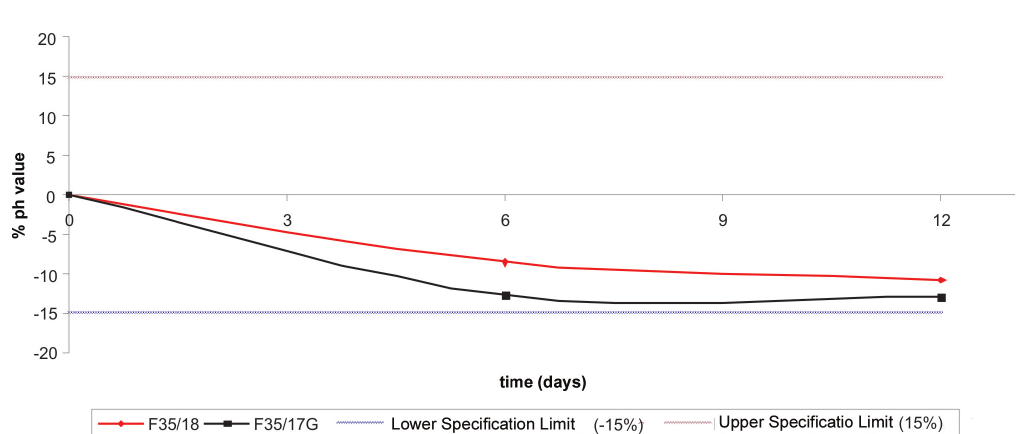
FIGURE 4 - Percentage variation of pH value for the test formulations F35/18 and F35/17G in the Freezing/Defrosting Cycles